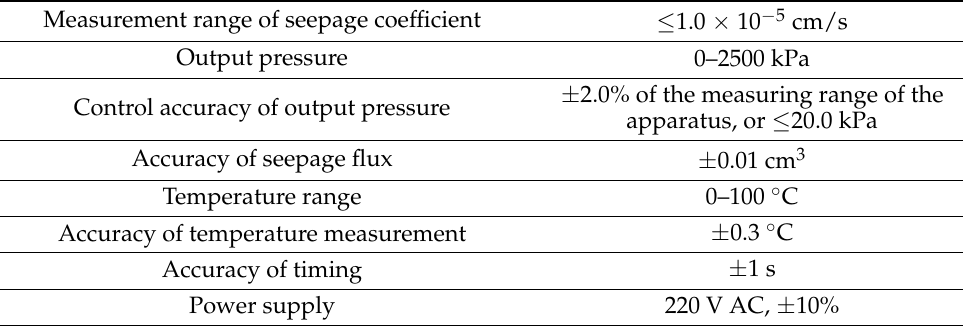
Table 2. Main technical parameters of the seepage